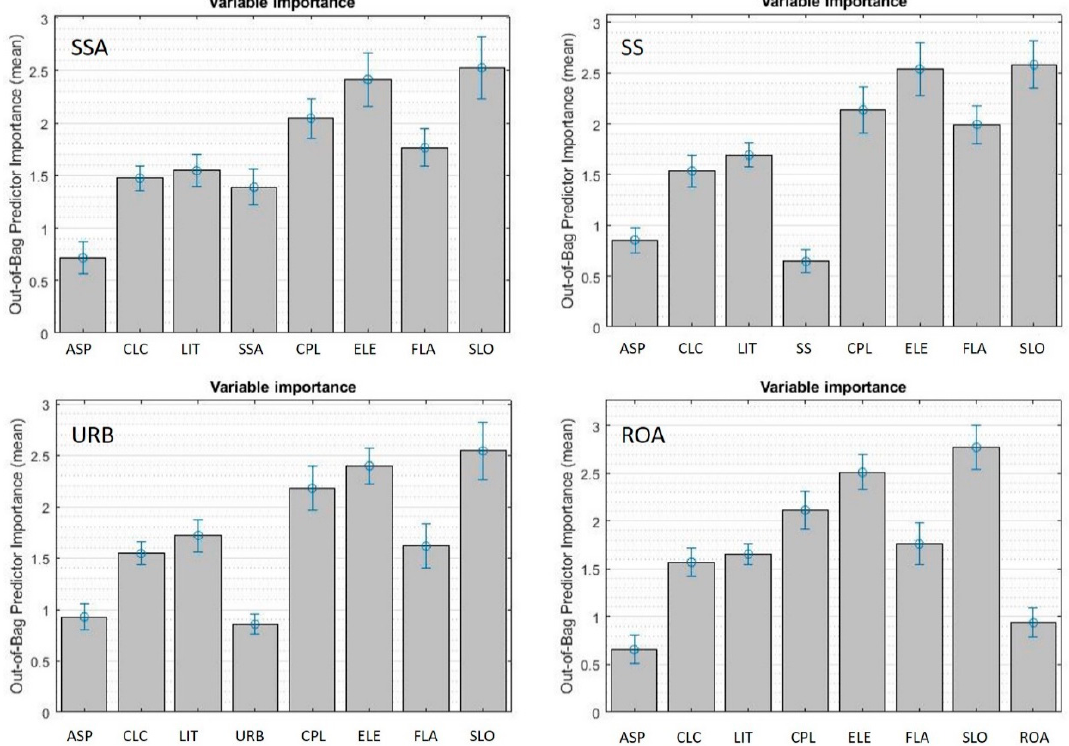
Figure 5. Relative importance of the variables used in each model configuration encompassing a soil sealing-derived parameter (see Section 2.5 for further explanations): Soil sealing aggregation (SSA); Soil sealing (SS); Roads (ROA); Urban density (URB). Blue bars represent the standard deviation.